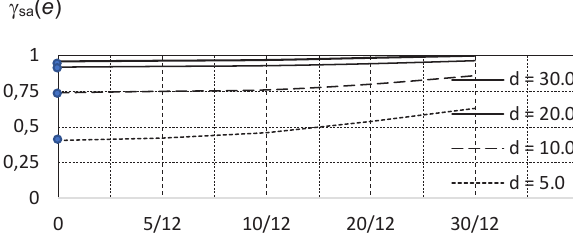
( e ) sa (m) and the load h